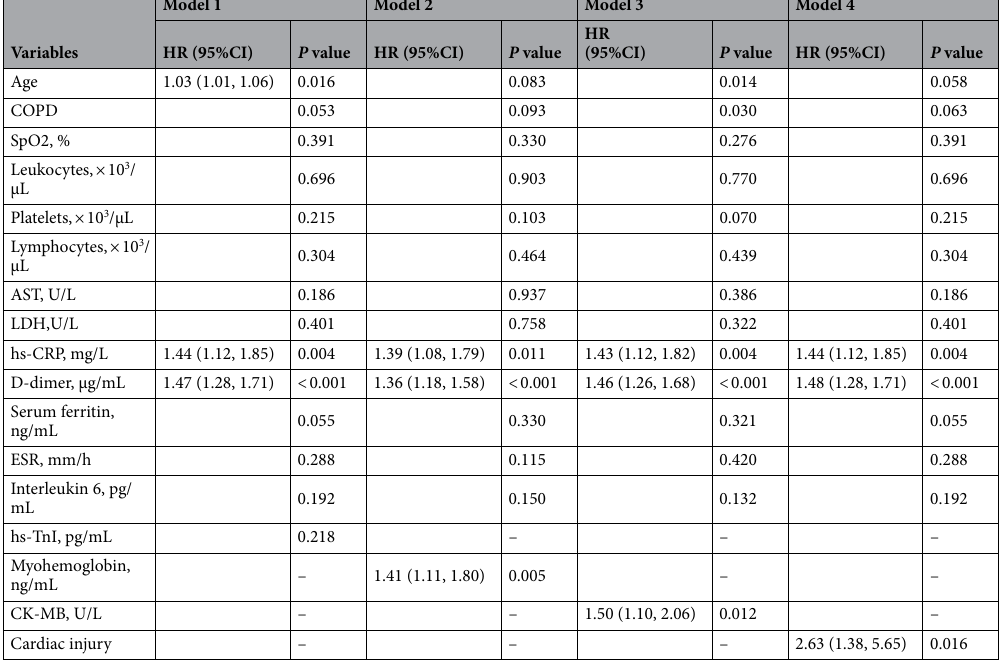
Table 3. Multivariate Cox regression analysis on the risk factors associated with mortality in patients. Cardiac biomarkers were included in Model 1, 2, 3 separately as continuous variables. Cardiac injury was included in Model 4 as binary